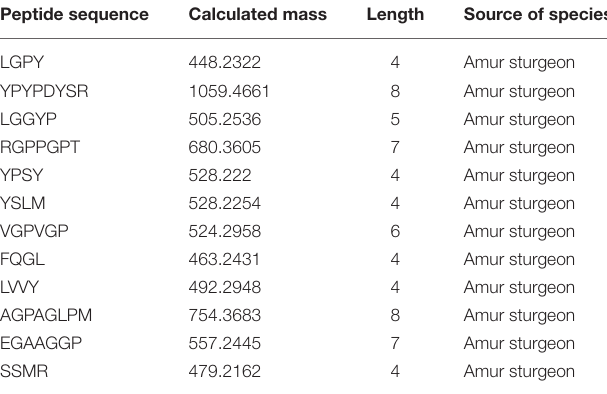
TABLE 3 | Peptide sequences identified by LC-MS/MS in the F3 from ESCH (results were shown based on the relative intensity of mass spectrum, peptide score, and molecular